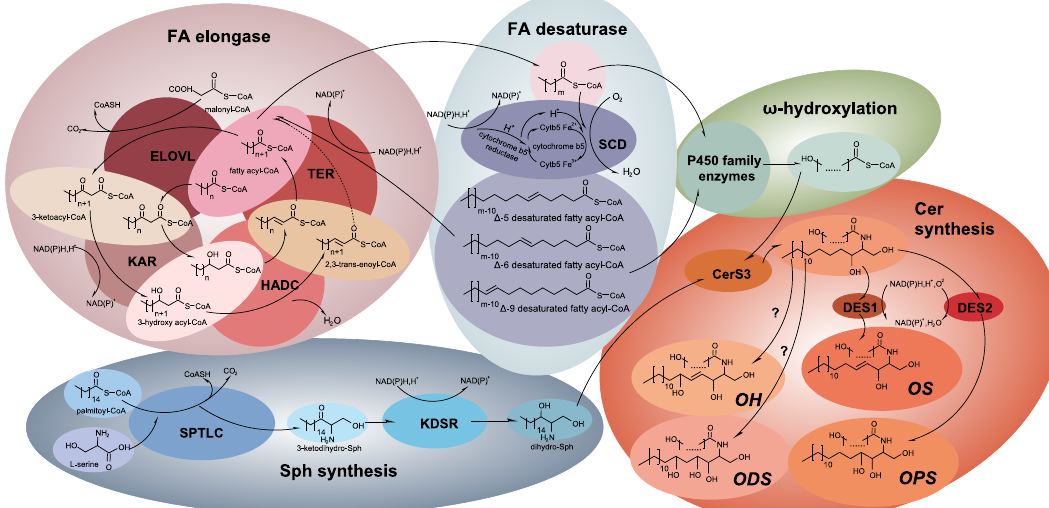
Figure 4. Overall methodology for de novo ω -OH-Cer biosynthesis. Pathways involved in de novo ω -OH-Cer biosynthesis, the detailed product molecule structure, and the key enzymes are shown.